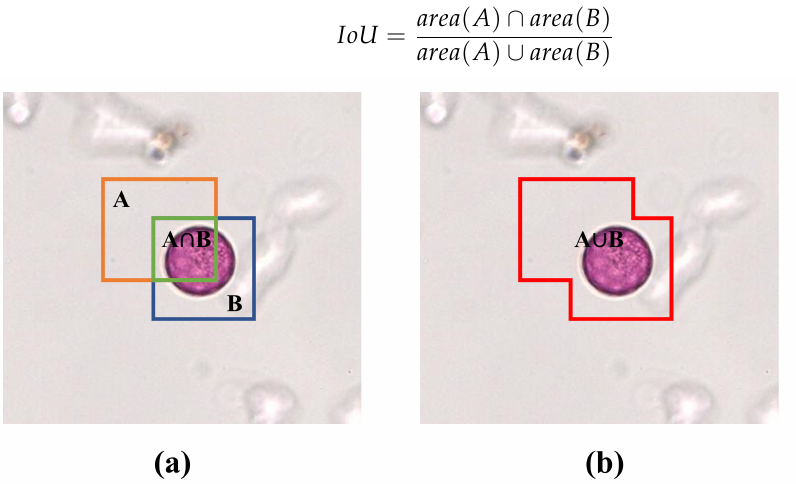
Figure 7. ( a , b ) The graph interpretation of IoU. A refers to the predicted bounding box and B refers to the ground-truth bounding